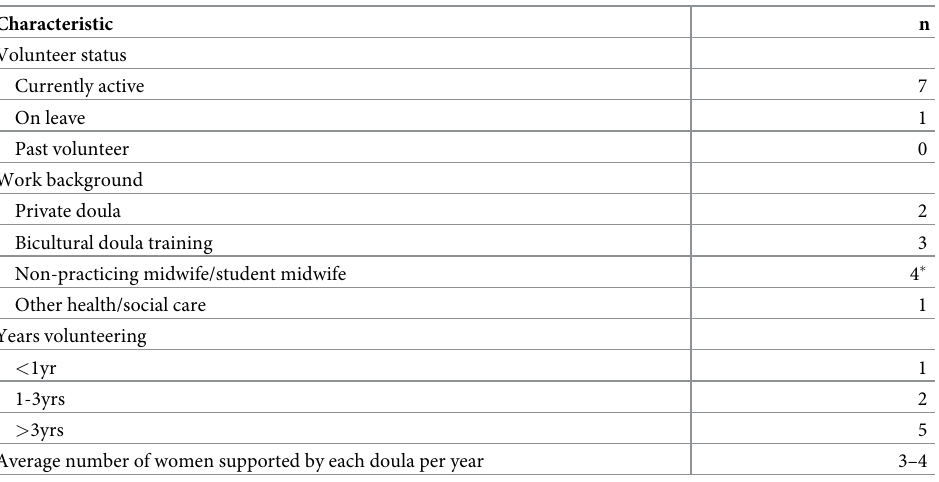
Table 2. Characteristics of focus group participants (volunteer